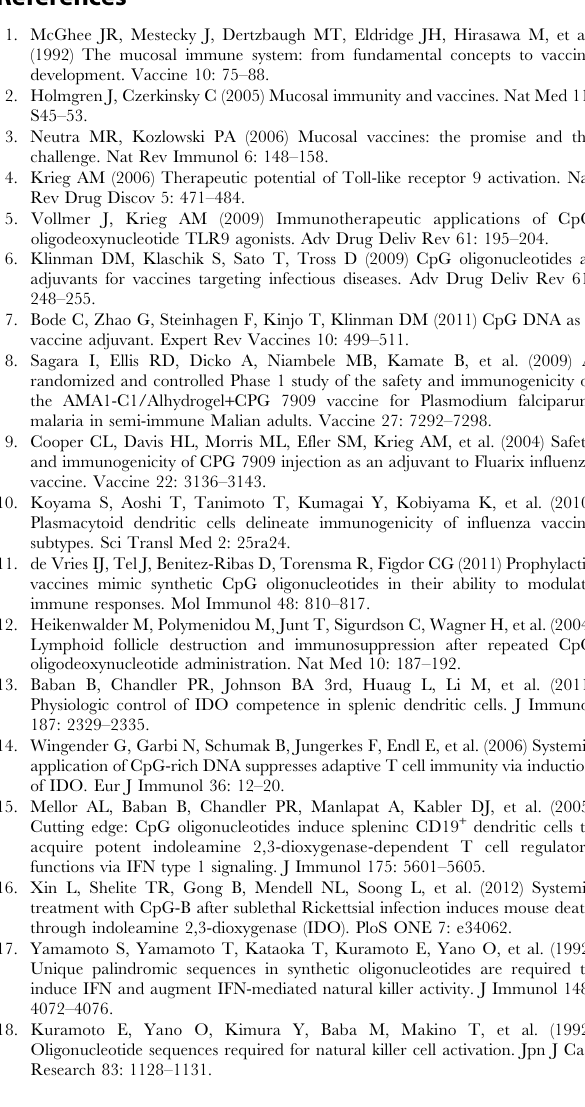
Figure S2 Nasally administered G9.1 raised DT-specific IgA response in sera. C57BL/6 and BALB/c mice were nasally vaccinated and serum titers of anti-DT IgA measured according to the protocol described in Fig. 3. * p , 0.05 and ** p ,